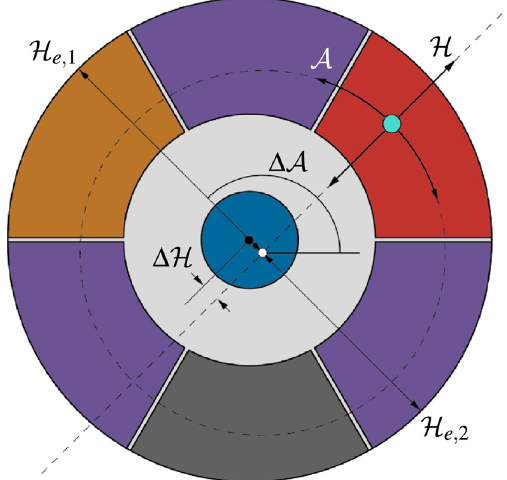
Fig. 6 Schematic of the movement of the source in the local motor coordinate system of the Compton Scanner, H and A . Also shown are the misalignment quantities, Δ H and Δ A , that define the misalignment between the center of the Compton Scanner frame (white point) and the center of the segBEGe detector (black point)